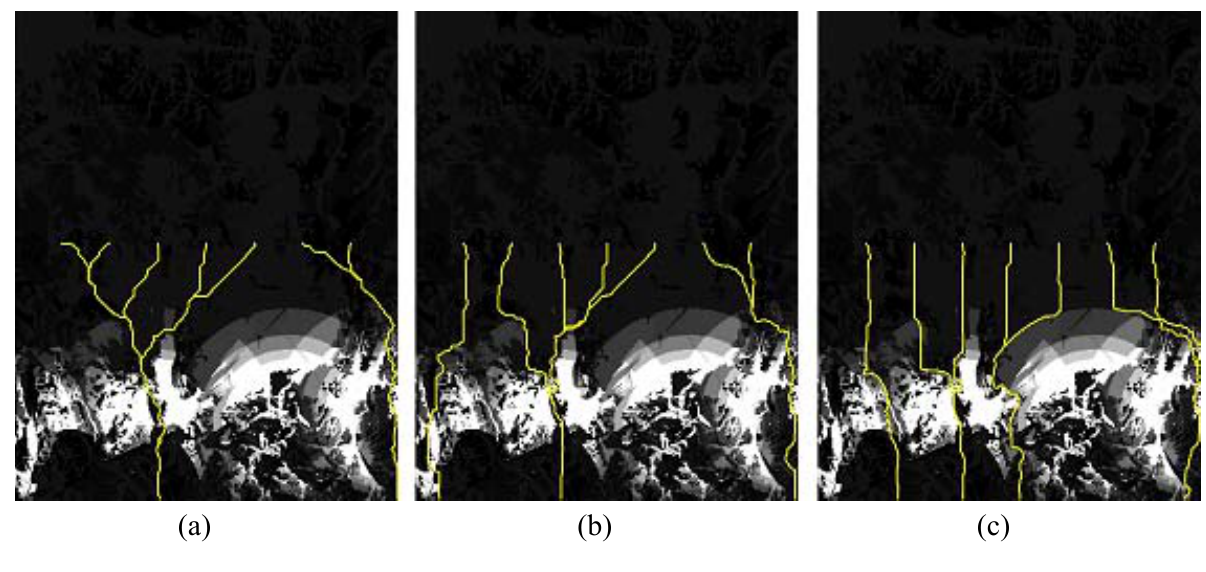
values. (a) μ = detect detect